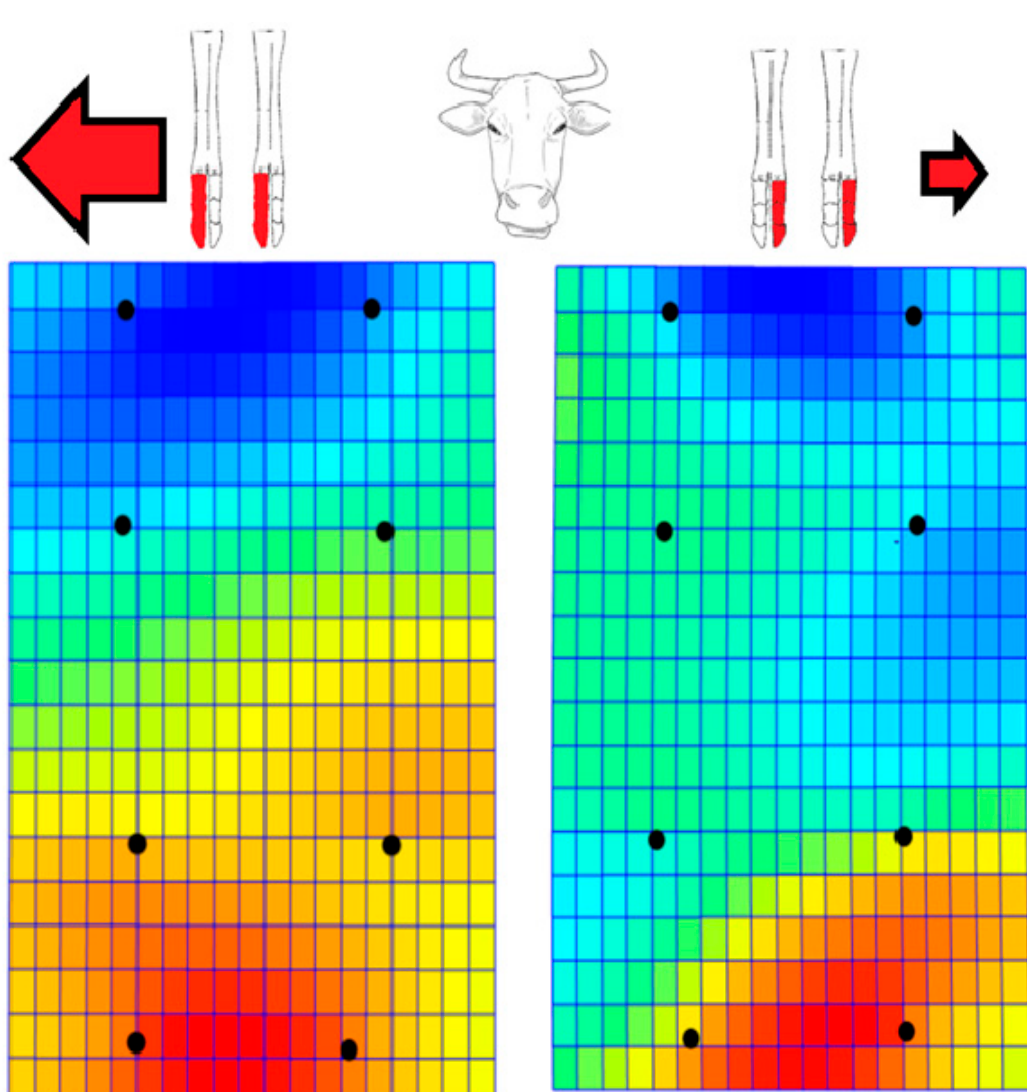
Figure 5. Representation of bending energy (contraction, bluish coloration and expansion, reddish coloration) for 17 paired limbs from 17 Pyrenean Brown calves (dorsal views). The right lateral series and left medial series on the left (above) appear on the left net frame (down) and the left lateral and right medial series (above) appear on the right net frame (down). The black dots equate to the previous landmarks (see Figure 1). We observed displacements of distal phalanges with a tendency towards abaxial displacements for paired acropodial series, which were more marked towards the